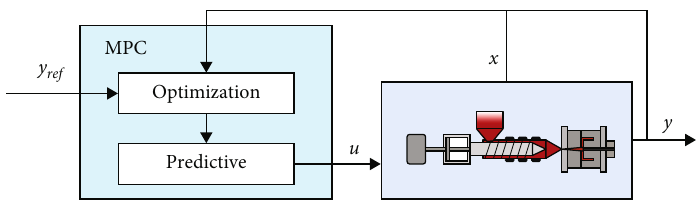
Figure 3: Schematic of the control process in IMM based on